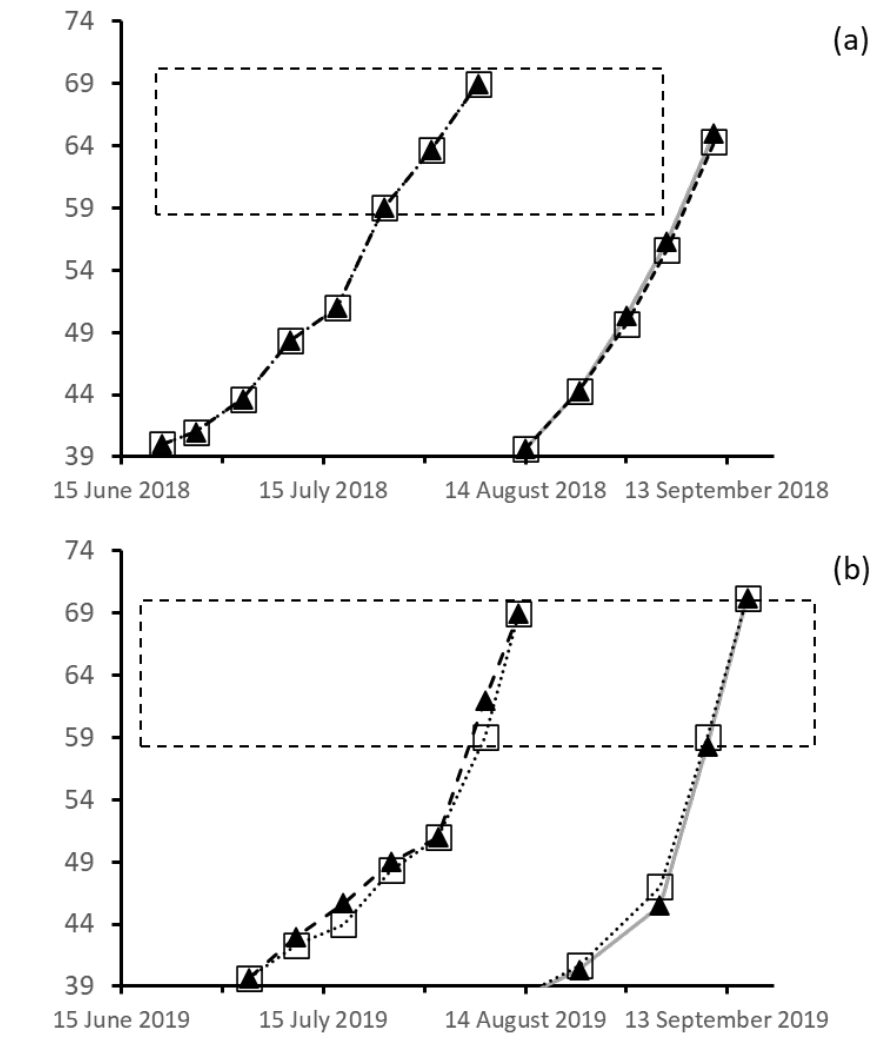
Figure 8. The crop development Zadok scores from Z40 to Z70 of heated (black triangle) and unheated (hollow square) plots ( n = 3) in 2018 ( a ) and 2019 ( b ) seasons at Dale. Values are average Zadok plot scores ( n = 3). Note: sub-plots were used in 2018 and paired plots were used in 2019 for heated and unheated treatments. The dashed box highlights the main susceptible period for wheat plants at the anthesis stage.